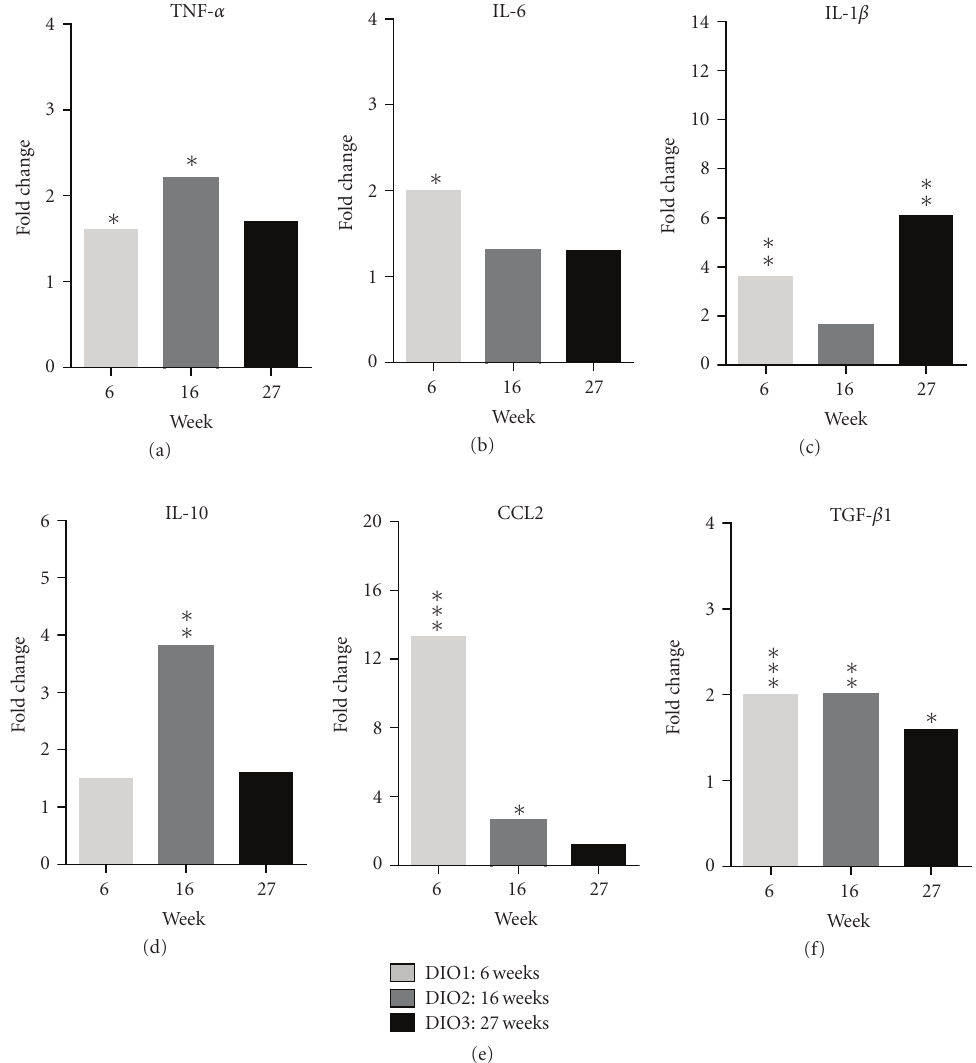
Figure 3: Induction of inflammatory mediators in whole EF assessed by gene expression at 6, 16, and 27-weeks. Data represented as HF/CH gene expression fold induction versus the Chow cohort for each time point. ( n = 7–10 mice for Chow and n = 10–15 mice for the HF/CH group). The light gray bars indicate the 6-week timepoint, the dark gray bars indicate 16-week timepoint, and the black bars indicate the 27-week timepoint. Statistical significance was determined by a two tailed Welch t -test; ∗ P < . 05, ∗∗ P < . 01, and ∗∗∗ P < .